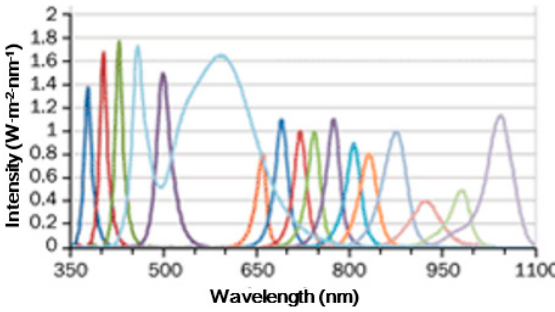
Figure 5. Individual spectra of 23 LEDs. Reproduced with permission from Ref. [63].